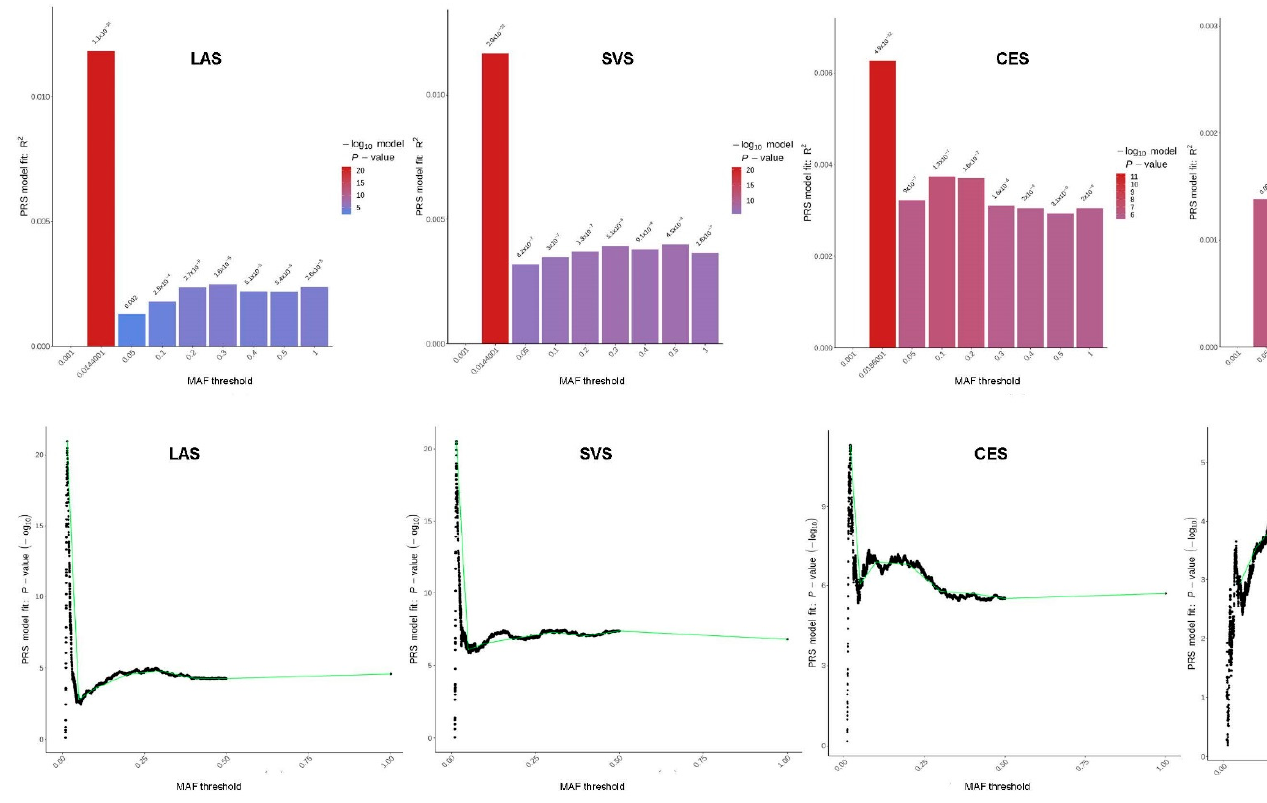
Figure 3. PRS derived from common genetic variants with low minor allele frequency (MAF < 0.025) provided the best-fit modeling for ischemic stroke when PRS was constructed based on the summary statistics of TOAST subtypes, such as LAS, SVS, and CES. PRS was constructed by PRSice-2. High-resolution plots were used to select the consistent cut-off value for the MAF threshold for PRS construction and the gene-set analyses. Discovery cases ( n = 1184) vs. controls ( n = 19,806). This figure adapted from Li J (2021) [24] with CC BY-NC-ND.